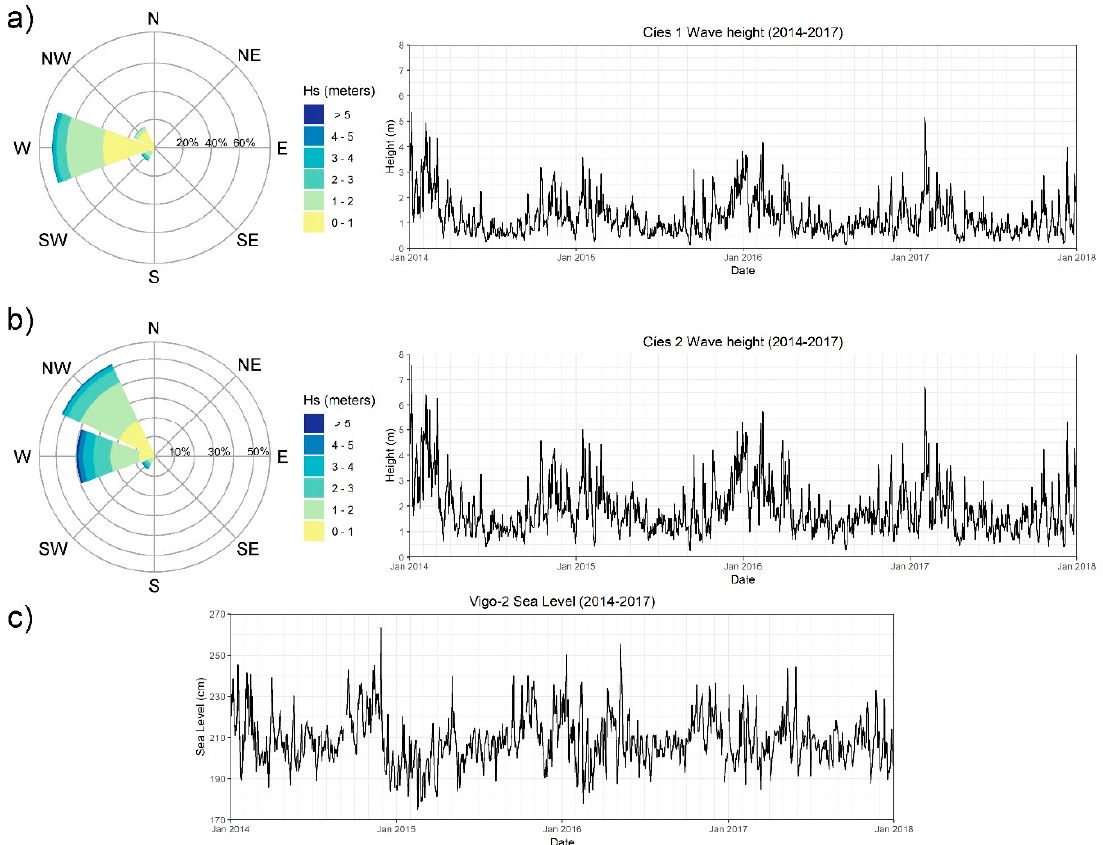
Figure 2. Wave data from Cíes Islands. ( a ) Cíes 1 is SIMAR point 3014007, which is localized in the north of the islands, and ( b ) Cíes 2 is SIMAR point 1044069, which is localized in the west of the archipelago. ( c ) Sea level data correspond to the Vigo-2 mareograph. Data were taken from Puertos del Estado (2018).